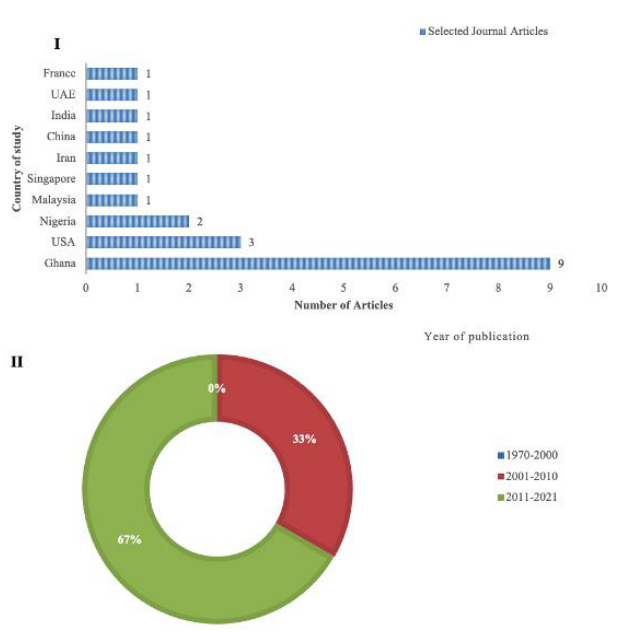
Figure 1: Distribution of Final Literature According to Country and Publication Year; (I) Journal Articles (II) Publication